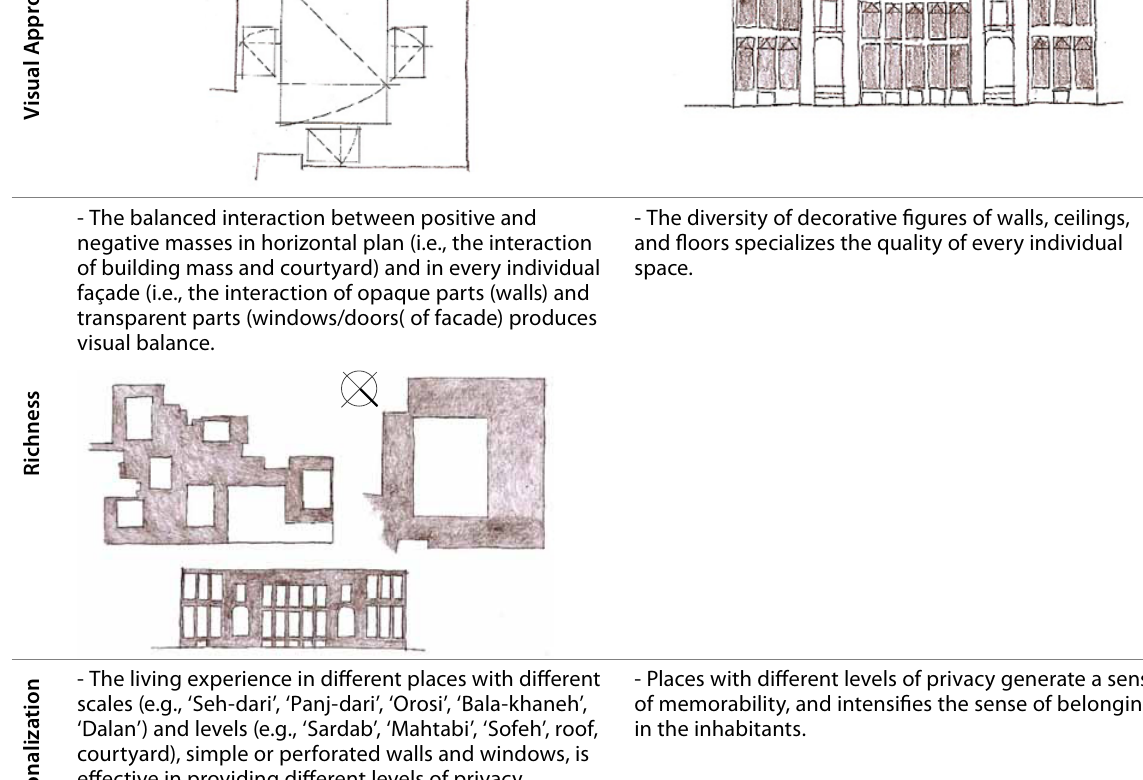
- The general proportion of facades is horizontal. The orientation of the frames of doors and windows is vertical. The composition of general horizontality of the facade and the vertical orientation of the frames produces a total visual balance.